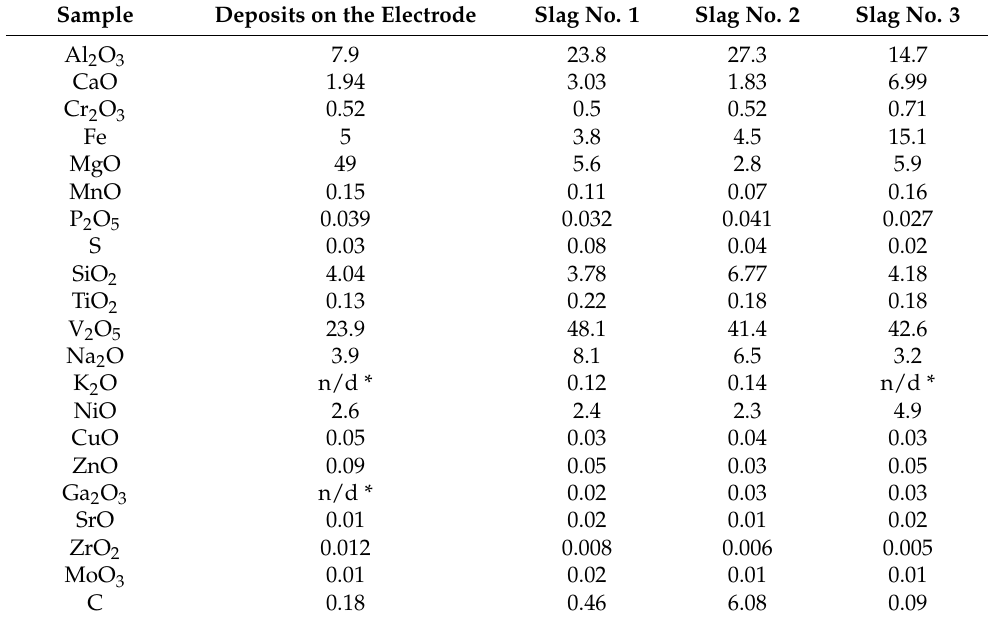
Table 3. Chemical composition of slag and deposits on the electrode,